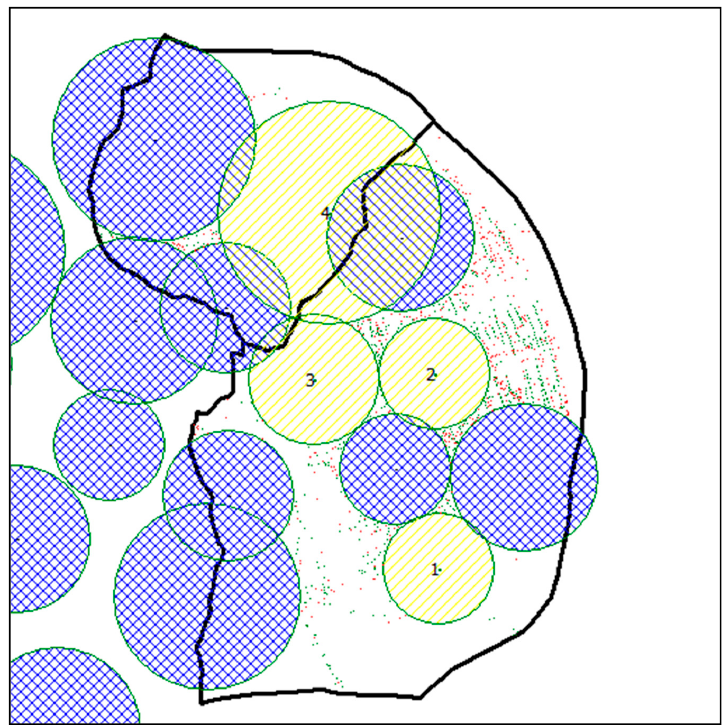
Figure 6. The four new floating stations suggested, with existing fire stations and uncovered EMS points with a capacity of 150 incidents per year during peak periods. Table 2. Results of the four floating stations installed.